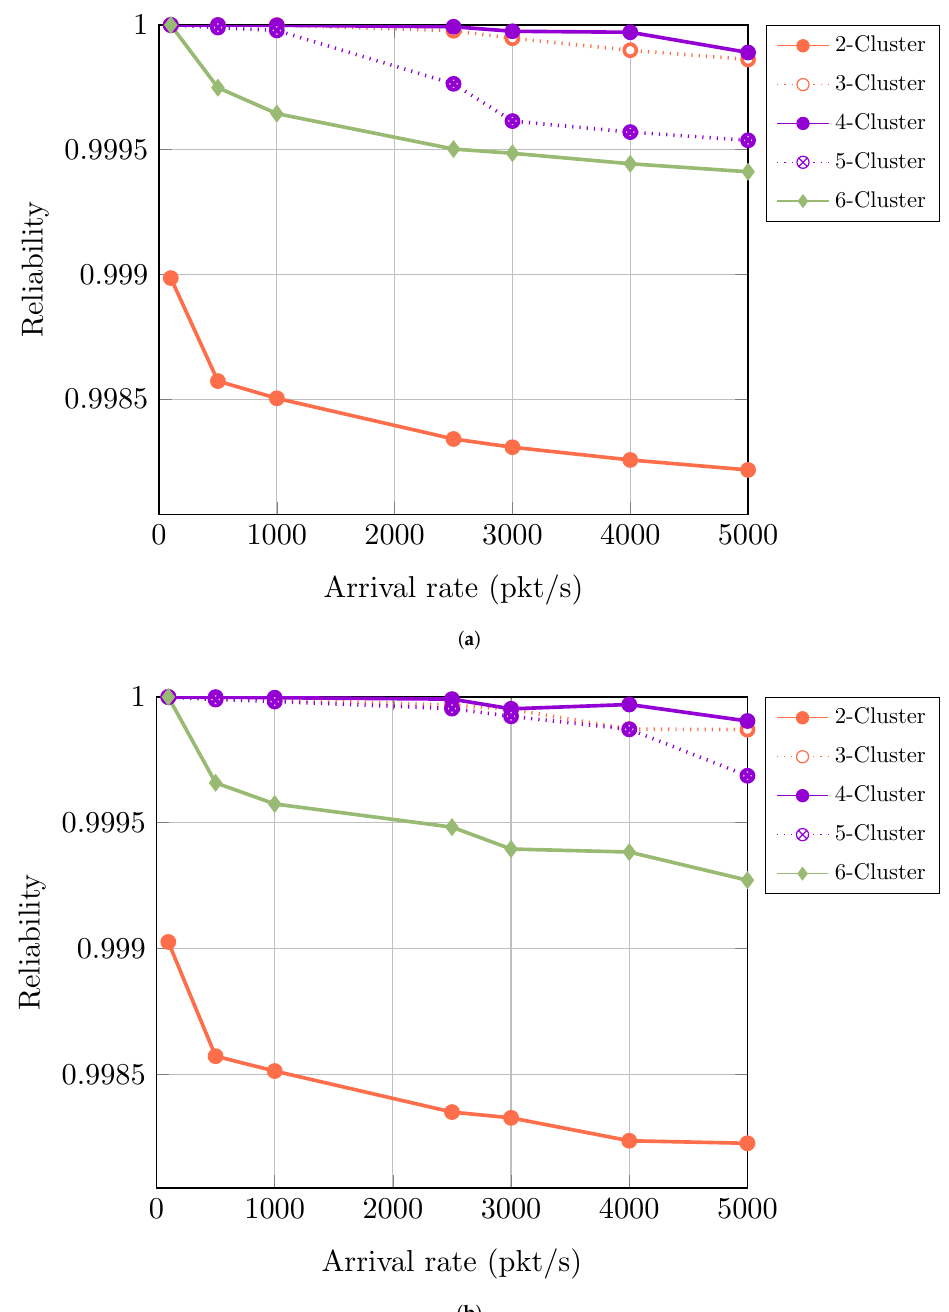
Figure 8. Determine reliability for different clusters using 3-packet duplication. ( a ) Mathematical, ( b )